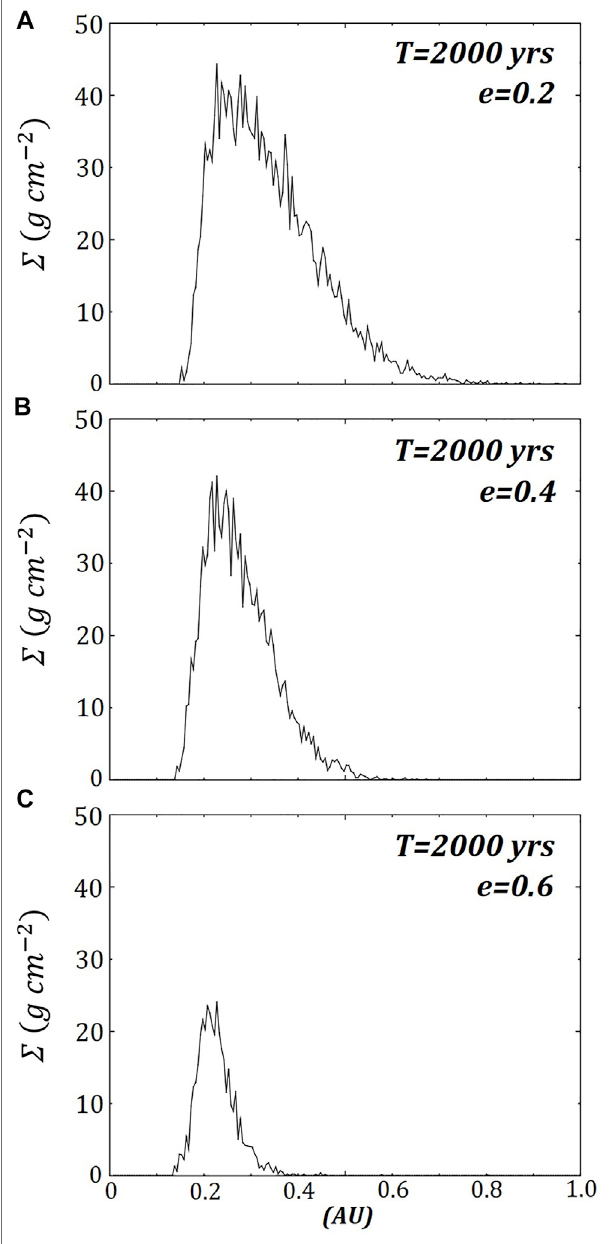
FIGURE 9 | The same three retrograde ring models (A) e = 0.2, (B) e = 0.4 and (C) e = 0.6 are shown in Figure 5 with their azimuthally averaged surface densities after 2000 years or ~182 complete orbits about the